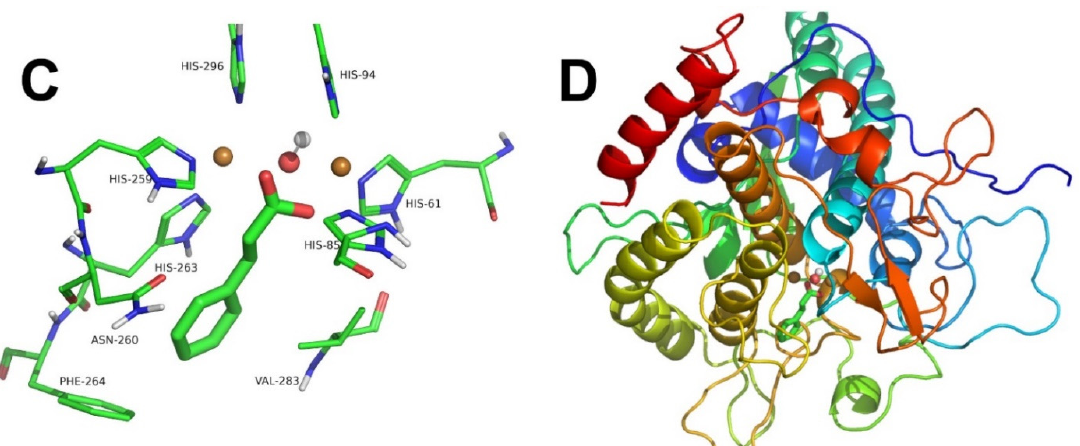
Figure 4. Docking of benzoate ( A , B ) and cinnamate ( C , D ) to met -tyrosinase. The binuclear active copper site in thin sticks ( A , C ) and the full structure of met -tyrosinase in ribbons ( B , D ) are depicted with the ligands. Colour scheme is as in Figure 3. Table 2. Compounds described as true inhibitors: competitive, non-competitive, uncompetitive and mixed. K d is the ligand dissociation constant of docking to the active site of oxy- and met-tyrosinase.